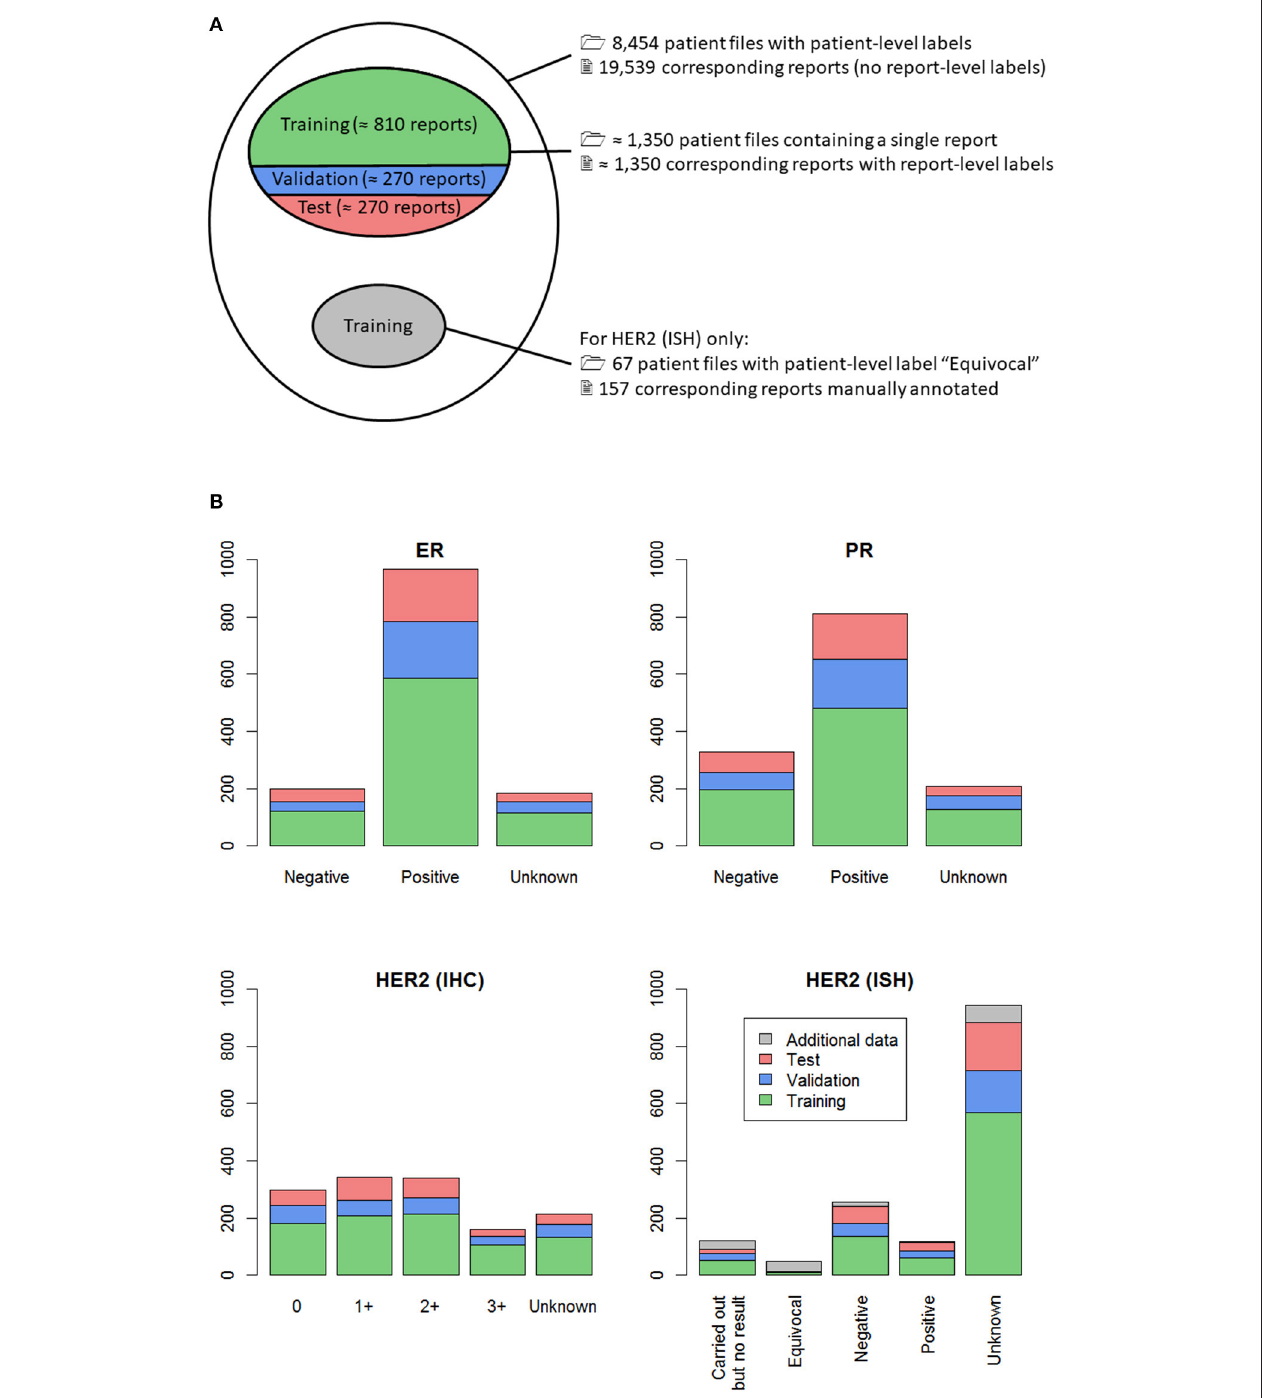
FIGURE 2 | (A) Venn diagram of all manually classified patient files (outer ellipse); (B) Distribution of the labels in the dataset, for the four classification tasks. (A) From all the manually classified patient files, those containing only one report were selected, so that a report-level label was available (upper inner ellipse). This subset of reports was randomly split into training (60%, green), validation (20%, blue) and test (20%, red) sets. For one of the four classification tasks, namely HER2 (ISH), all patient files with patient-level label “Equivocal” were selected, resulting in 67 patient files, shown in gray. The corresponding 157 reports were individually labeled, and these report-level labels were added to the training set for classification of HER2 (ISH). (B) Split of the data in training (green), validation (blue) and test sets (red) is shown, along with additional classified data for HER2 (ISH) (gray). For each classification task, training data (green + gray) was used to build several machine learning classifiers, which were evaluated on the separate validation set (blue) to avoid overfitting. Once the best classifier was selected, its performance was assessed on the held-out test set (red).